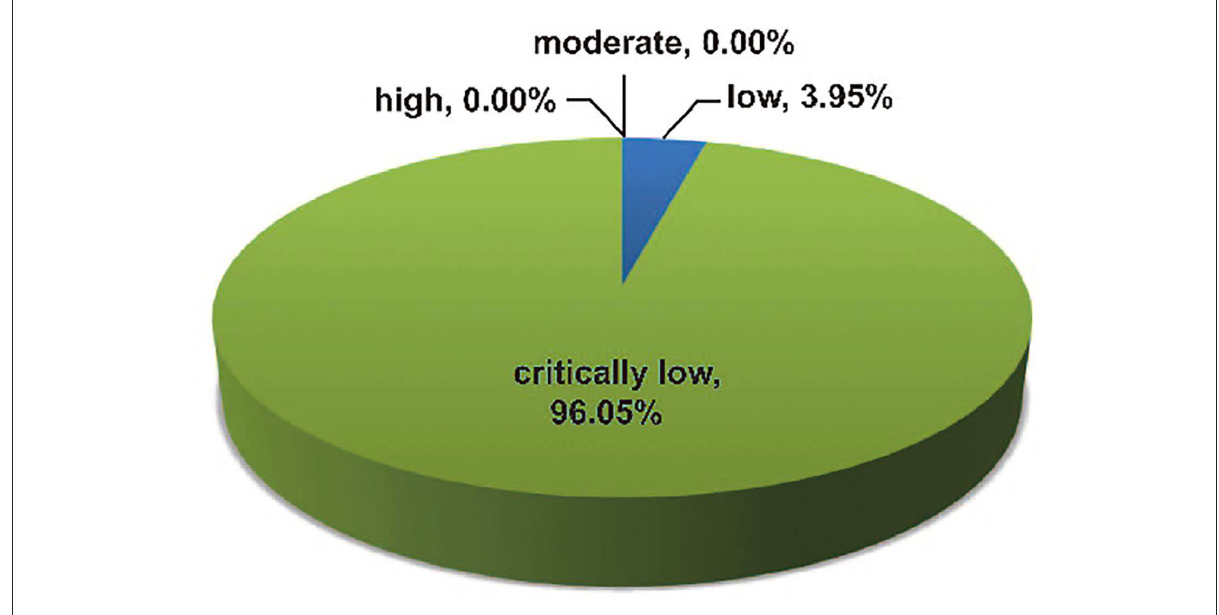
FIGURE10 Map of results of AMSTAR 2 scores.